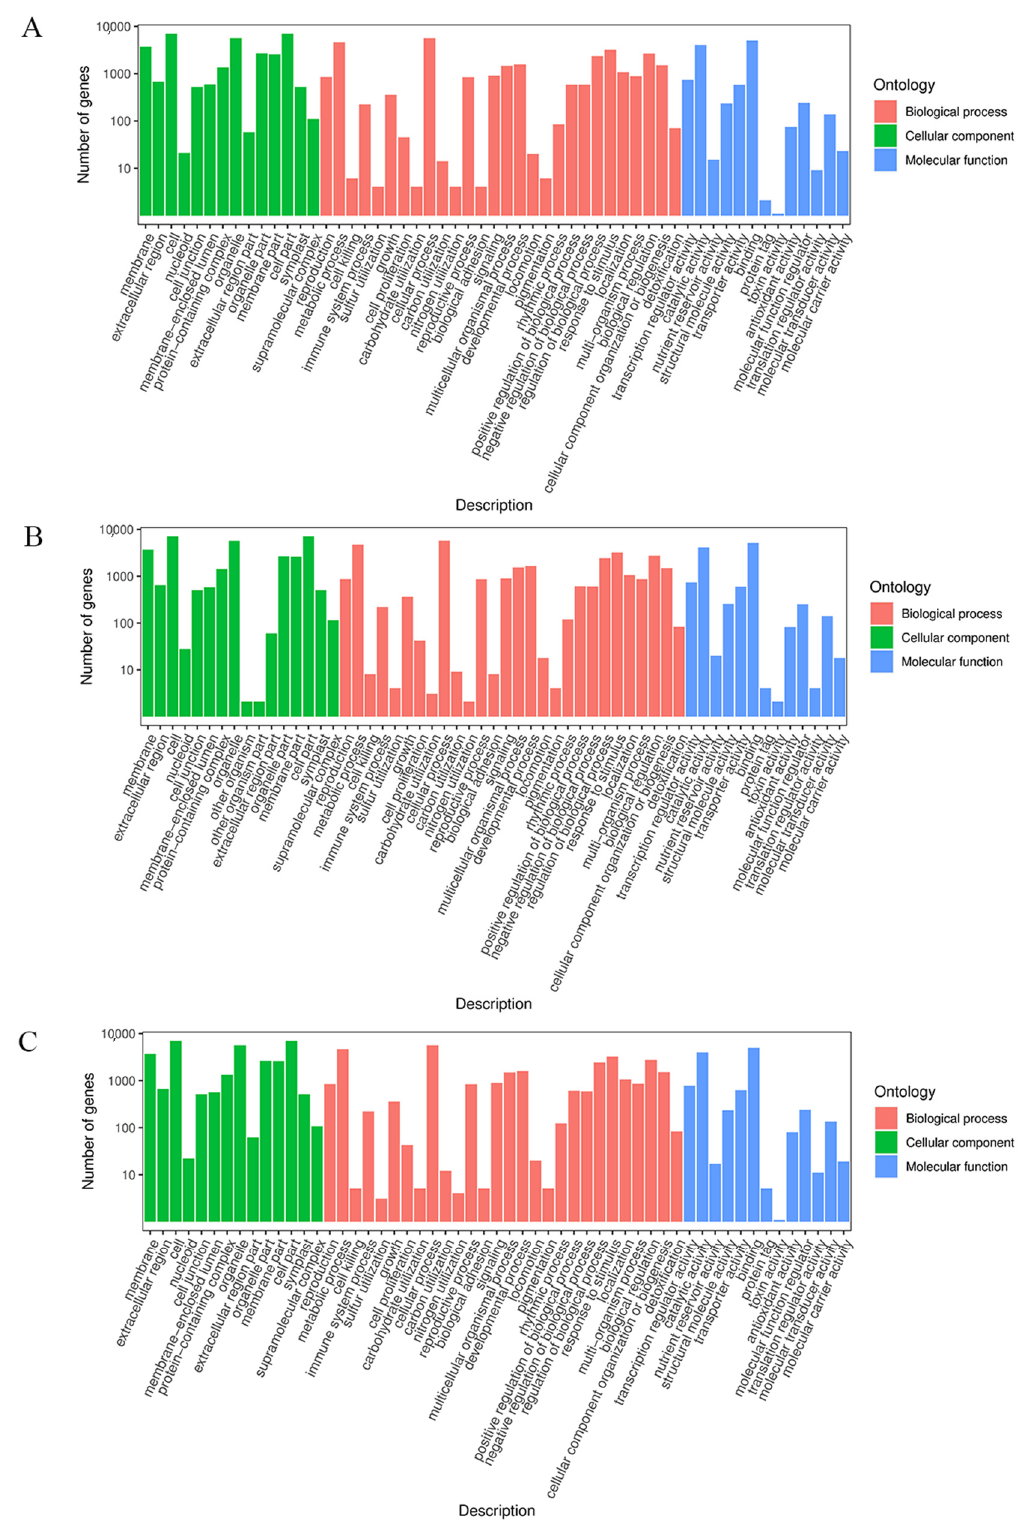
Figure 7. GO analysis of the DEGs. ( A ) GO functional classification of DEGs between Y and LP. ( B ) GO functional classification of DEGs between Y and YP. ( C ) GO functional classification of DEGs between Y and P. Red arrows indicate the DEGs associated with metabolic processes.